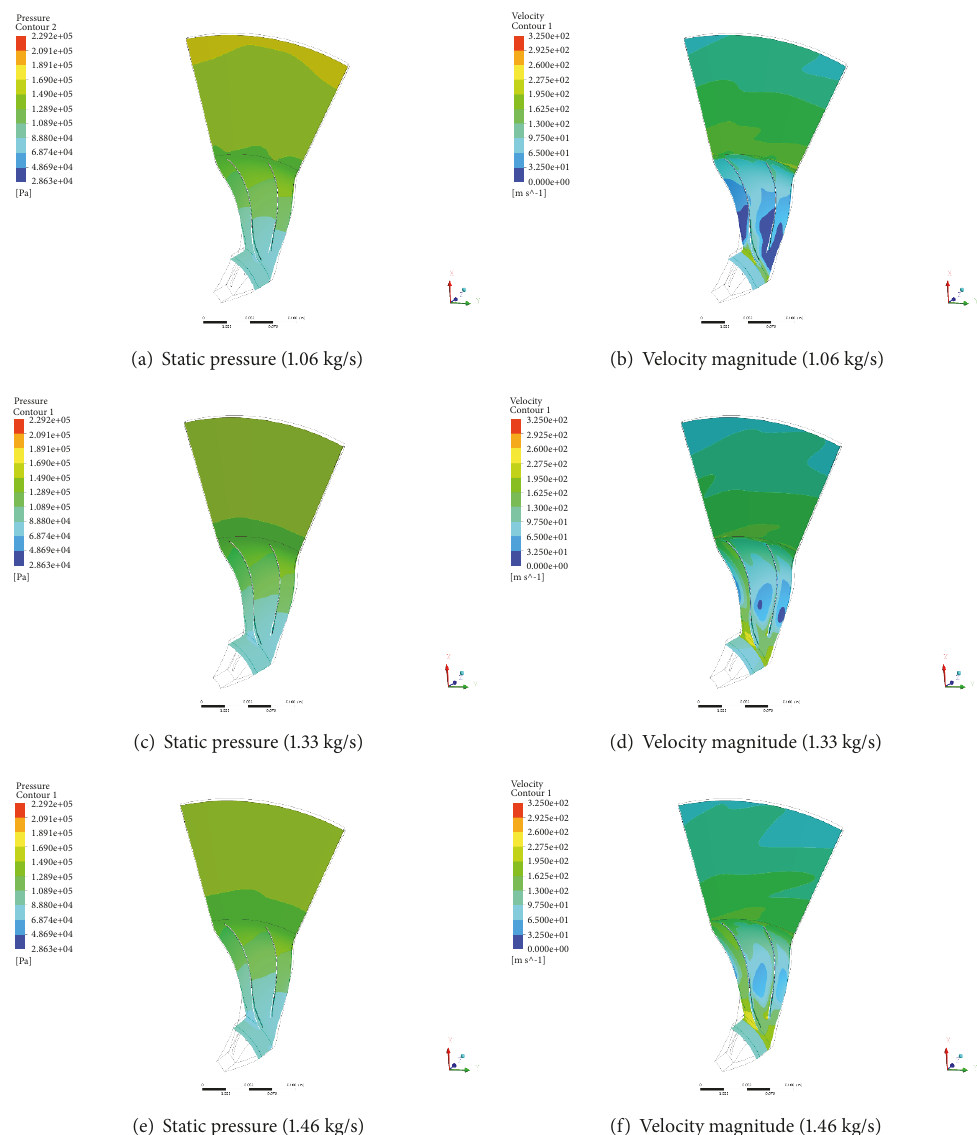
Figure 14: Static pressure and velocity magnitude contours at 368